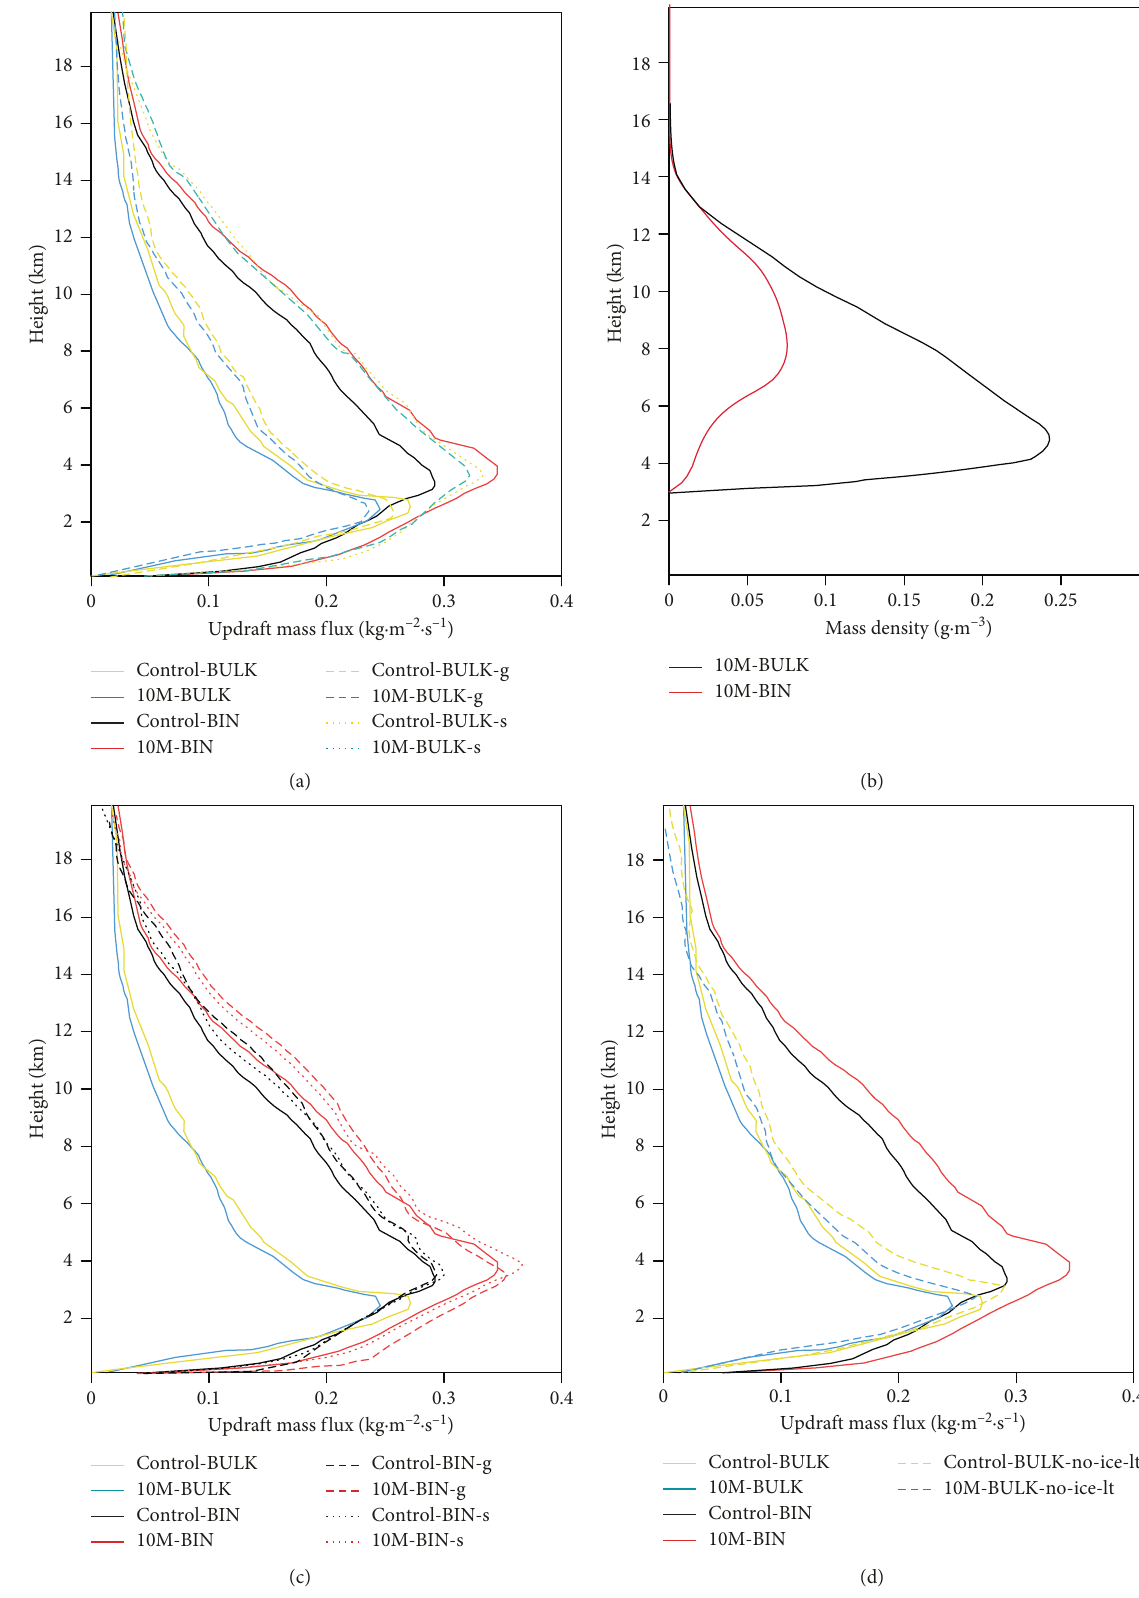
Figure 6: (a) Vertical distributions of the time- and domain-averaged updraft mass fluxes for the standard runs, the control-BULK-g run, the 10M-BULK-g run, the control-BULK-s run, and the 10M-BULK-s run. (b) Vertical distributions of the time- and domain-averaged snow mass density for the 10M-BULK run and the 10M-BIN run. (c) Vertical distributions of the time- and domain-averaged updraft mass fluxes for the standard runs, the control-BIN-g run, the 10M-BIN-g run, the control-BIN-s run, and the 10M-BIN-s run. (d) Vertical distributions of the time- and domain-averaged updraft mass fluxes for the standard runs, the control-BULK-no-ice-lt run, and the 10M-BULK-no-ice-lt